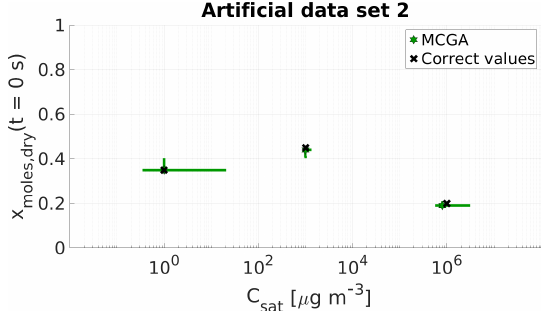
Figure 3. Parameter estimates for artificial data set 2; dry particle mole fraction at the start of the evaporation and saturation concen- trations of three model compounds were optimized to match the data. Green stars show the MCGA estimates and black crosses the correct values. The whiskers show the 10th and 90th percentiles of the estimated variable distributions.